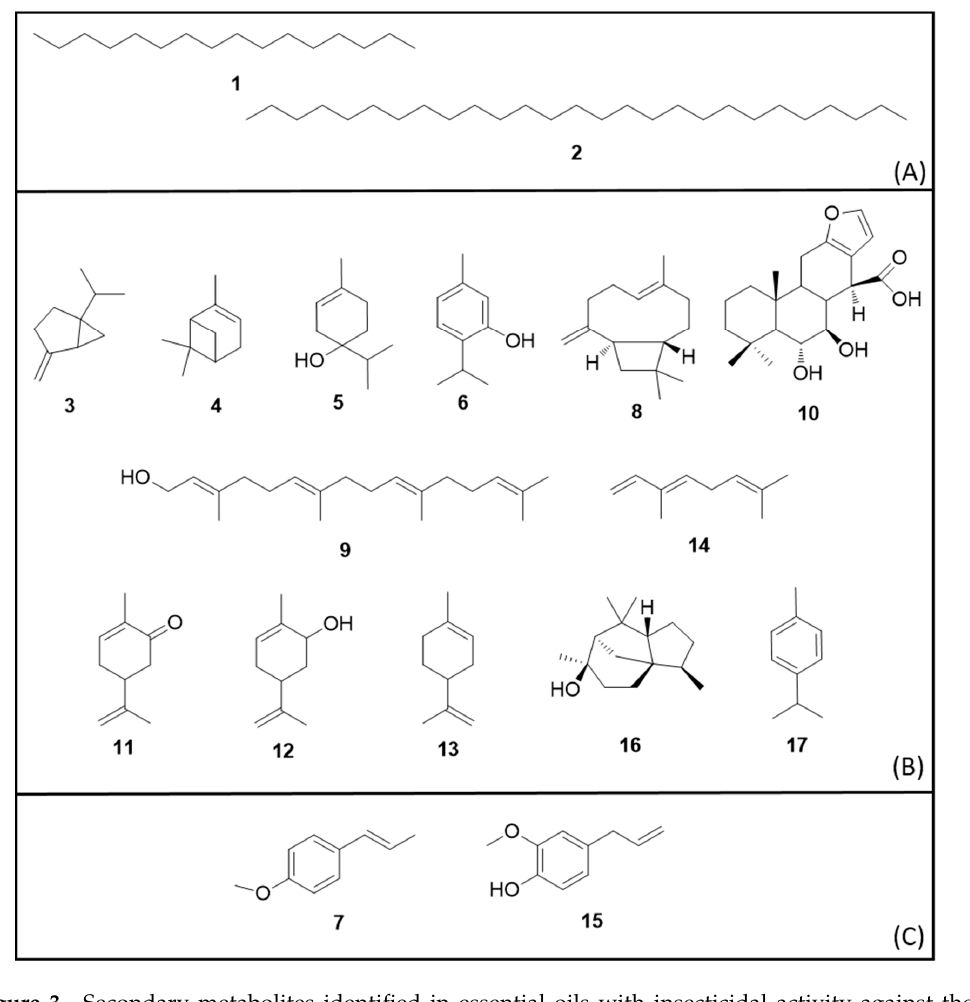
Figure 3. Secondary metabolites identified in essential oils with insecticidal activity against the Ae. aegypti . ( A ) Alkanes ( B ) Terpenes and ( C )